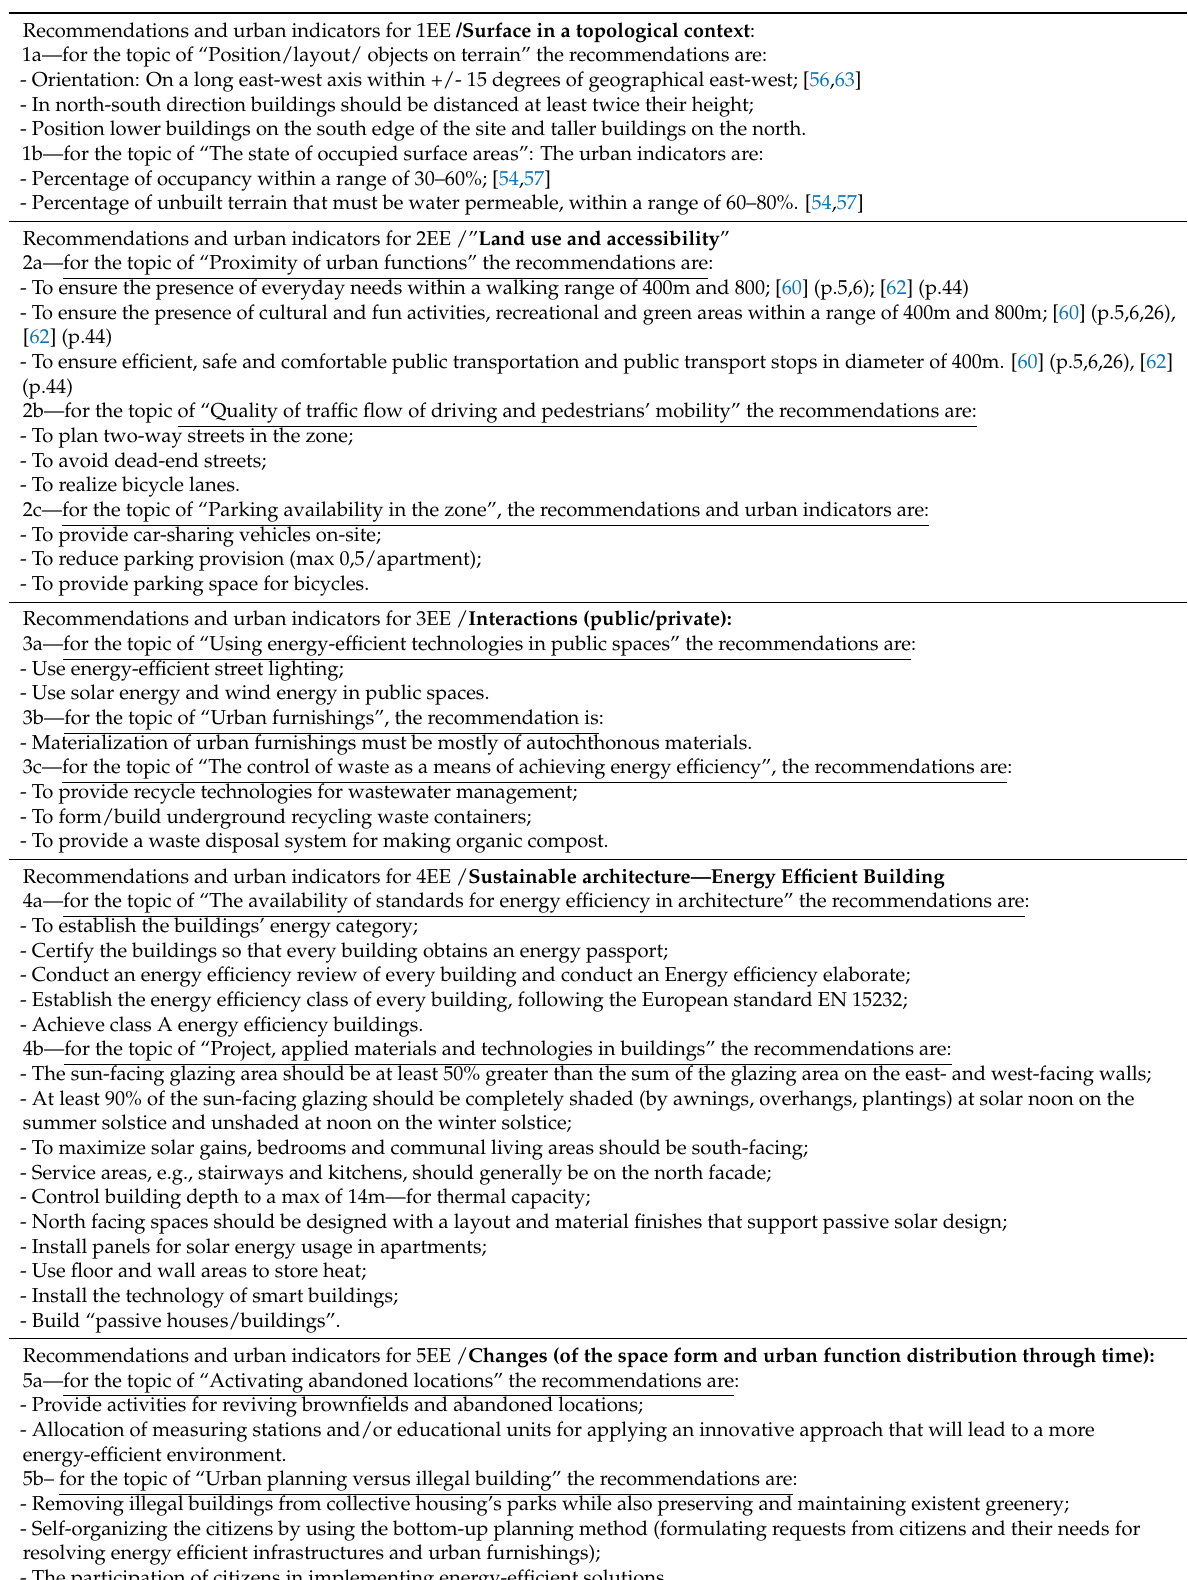
Table 1. Wider based recommendations and urban indicators for achieving energy efficiency of urban clusters—thematic sub-groups. ( Sources for defining the recommendations: